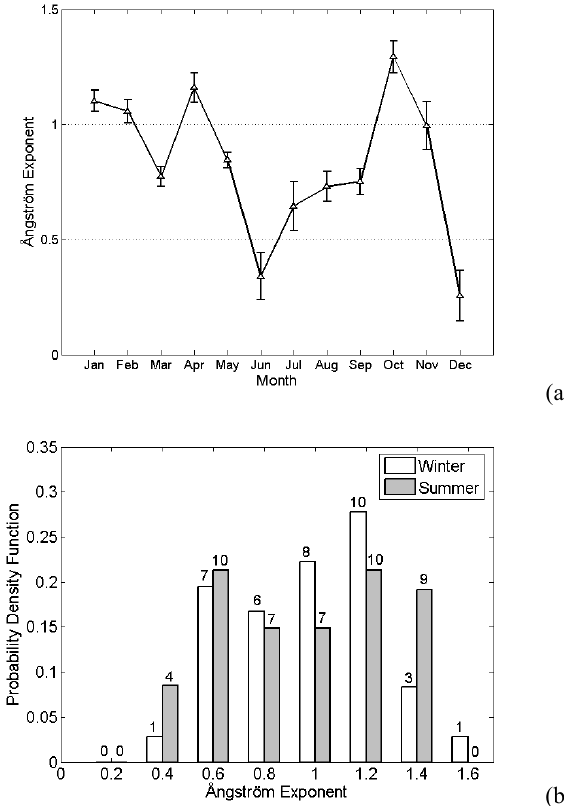
Fig. 5. Lidar-derived daytime backscatter-related Ångström exponent: (a) Annual cycle; (b) probability density function. The numbers above the bars indicate the number of observation days.